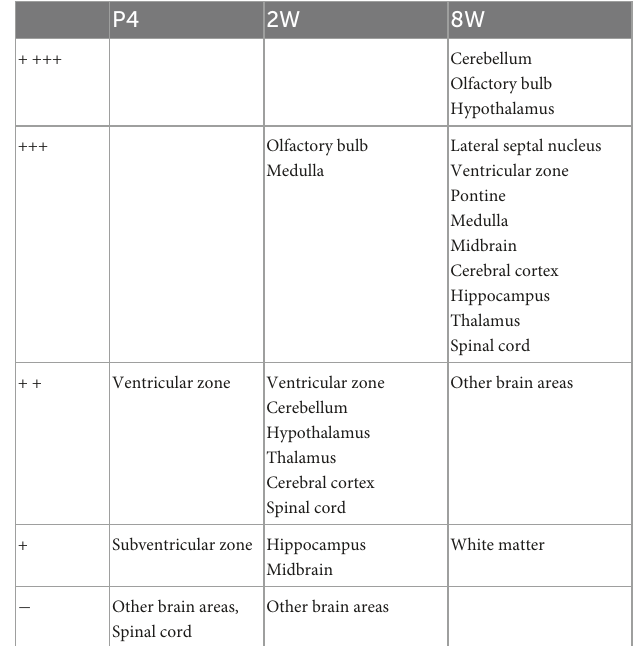
TABLE 2 Summary of expression of ETNPPL in the whole